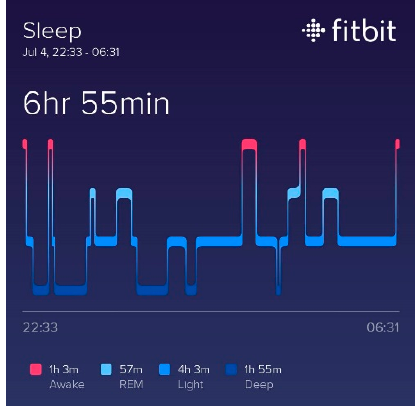
Figure A16. Sydney, Australia.